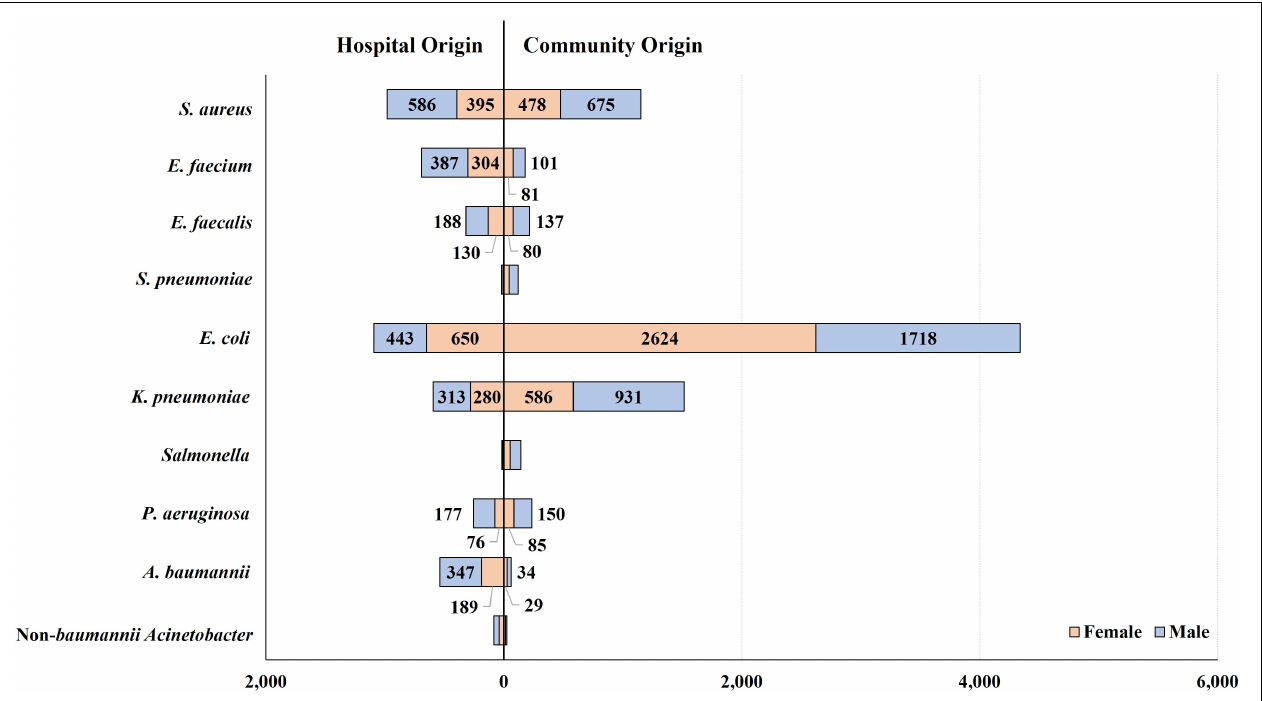
FIGURE 2 | Occurrence of bloodstream infections by patient group, categorized by patient sex and type of infection. E. coli- caused BSIs occurred 1.5-fold more frequently in female patients than in male patients, in contrast to the other bacterial BSIs: in terms of the relative incidence of BSI in females to that in males, 0.7 were caused by S. aureus , 0.8 by E. faecium , 0.7 by E. faecalis , 0.7 by K. pneumoniae , 0.5 by P. aeruginosa , and 0.6 by A. baumannii . By type of infection, most Salmonella (91.1%, 144/158) and S. pneumoniae (87.6%, 120/137) isolates were recovered from patients with CO infection, and E. coli was isolated from CO infection four times more frequently than from HO infection. In contrast, A. baumannii and E. faecium presented the opposite relative frequency of HO infection, as 8.5 and 3.8 times more were isolated from patients with HO infection than those with CO infection, respectively. S. aureus was evenly isolated from patients with CO and HO